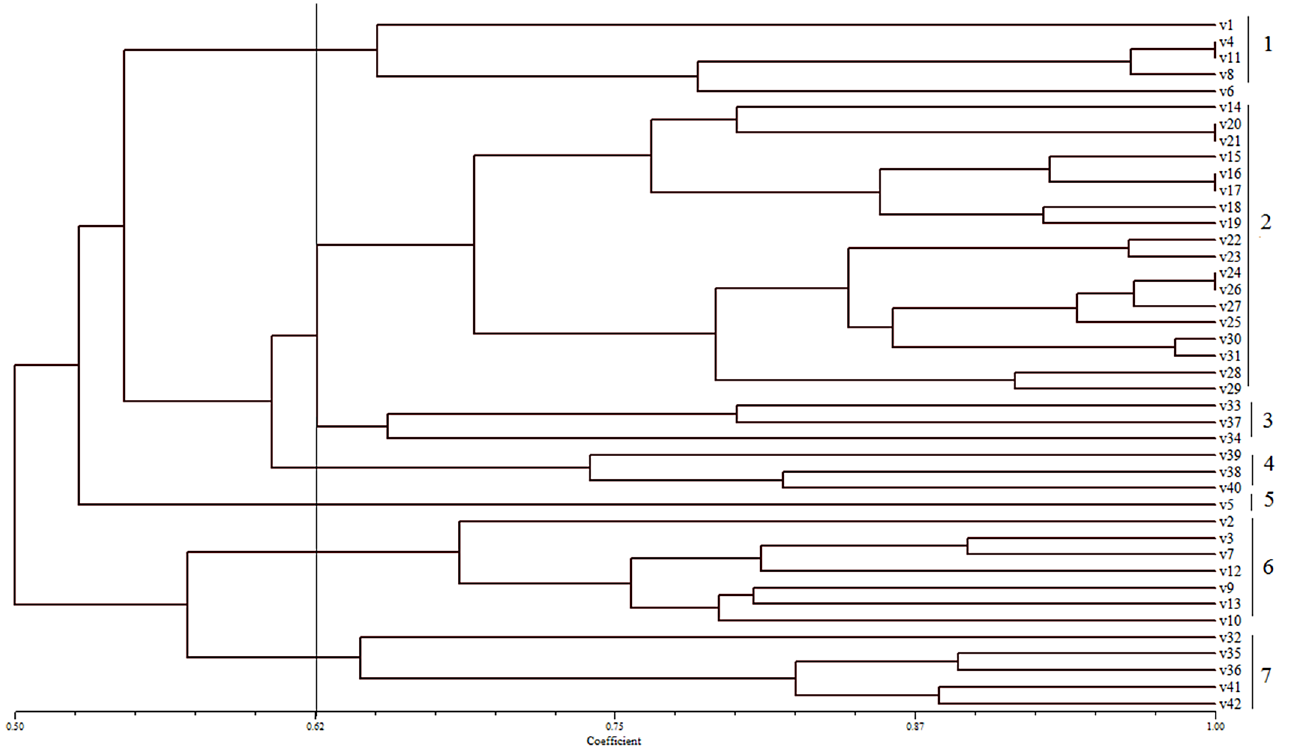
Fig 2. Dendrogram constructed from SSR marker